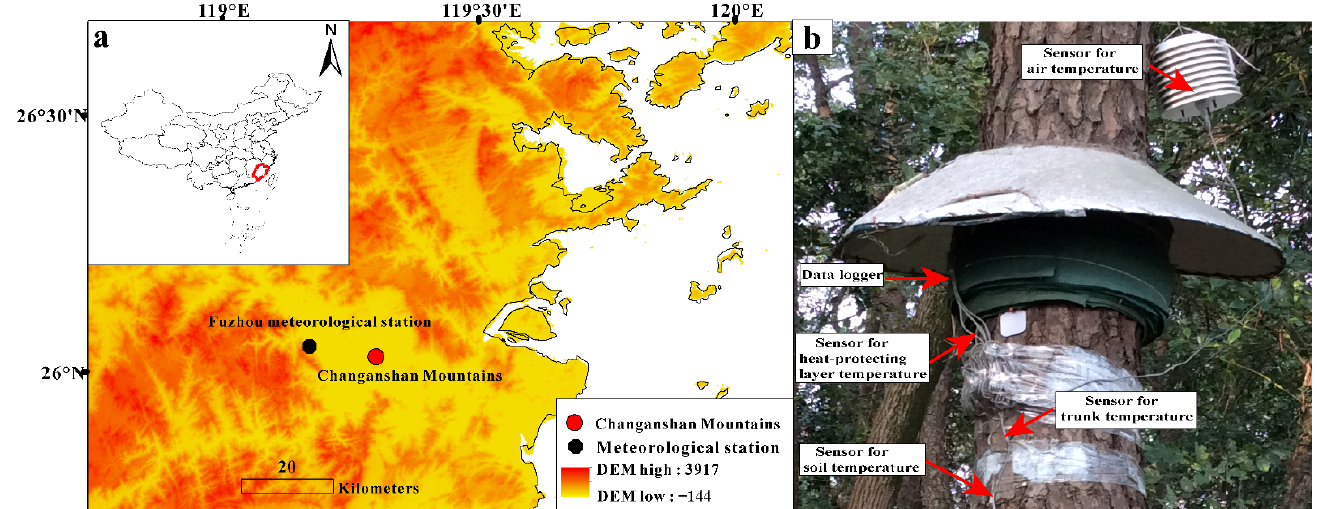
Figure 1. ( a ) Location of the Changanshan site in Fujian province of China, ( b ) photos of monitoring instruments on trees at Changanshan site. The temperature sensors were equipped in the heat-protecting layers, the soil beneath the forests, ambient air and the uncovered trunks, respectively.